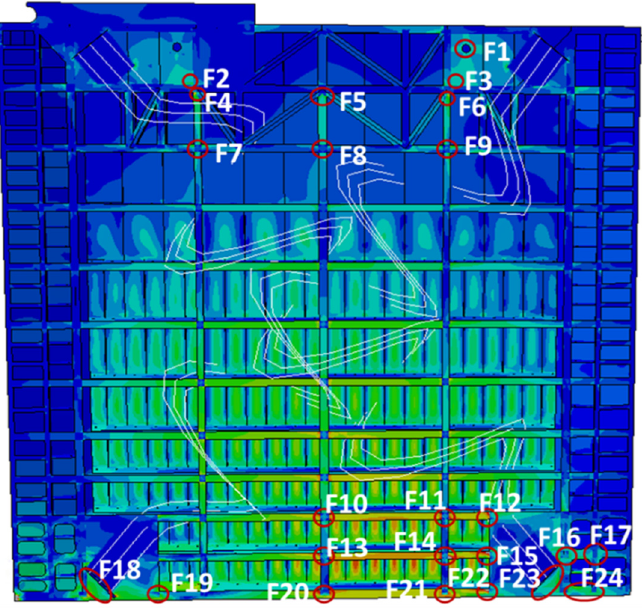
Figure 6. Greenup Lock and Dam von Misses stress contour during a lockage cycle. The damage caused by one water-elevation-change cycle for each gate component was Table 2. Fatigue damage calculations of critical sections. determined using Miner’s linear damage accumulation rule, as presented in Equation (1), where D i is the total damage, n i is the number of cycles, and N i is the number of cycles to failure at a given stress range. N i can be calculated from the AASHTO fatigue capacity